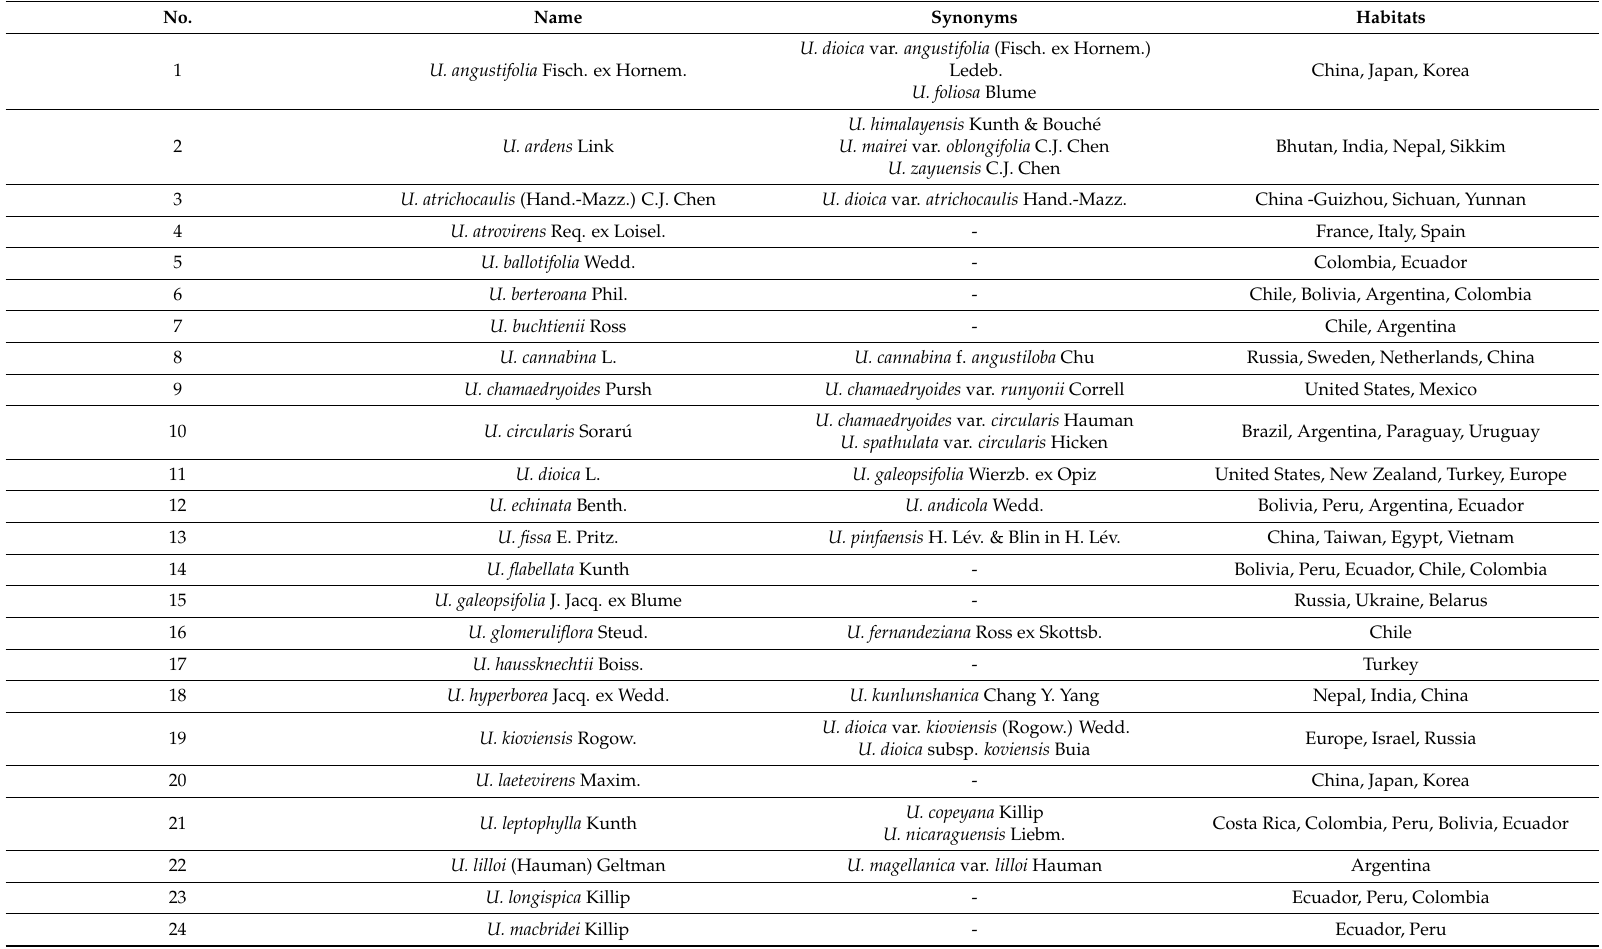
Table 1. The list of species belonging to the Urtica genus